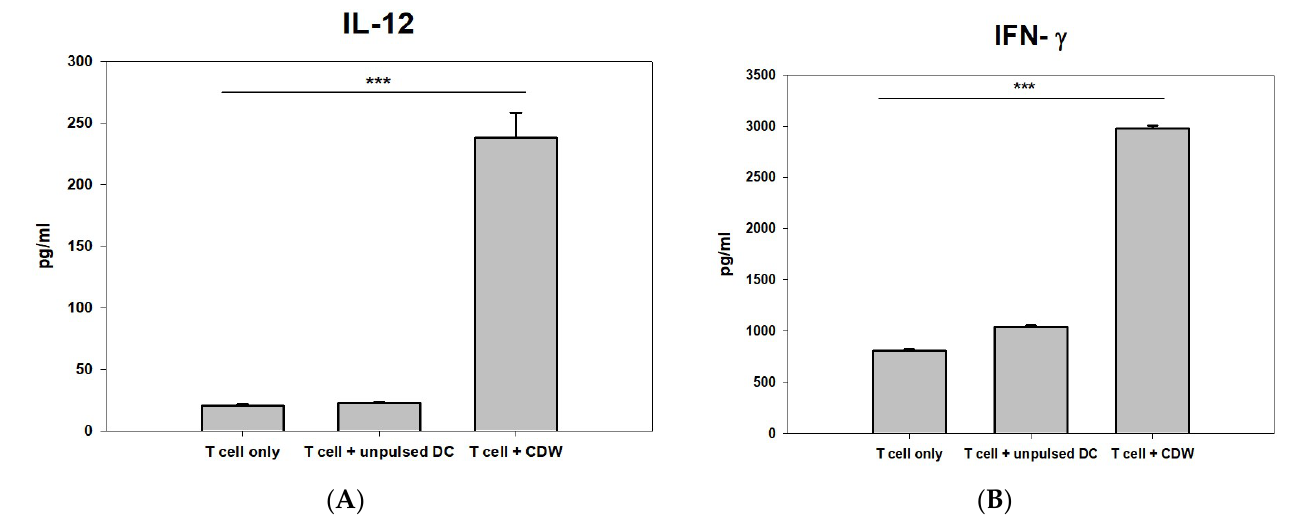
Figure 3. Induction comparison of CDW on T cells via cytokine analysis. The secretion of IL-12 ( A ) and IFN-γ ( B ) was measured in T cell only (activated IL-2 and Trans ACT), T cell + unpulsed DC, and T cell + CDW co-culture supernatant using ELISA assay (n = 3). ELISA was performed using the supernatant at the time of completion. Analysis was performed through SigmaPlot. *** p < 0.001.